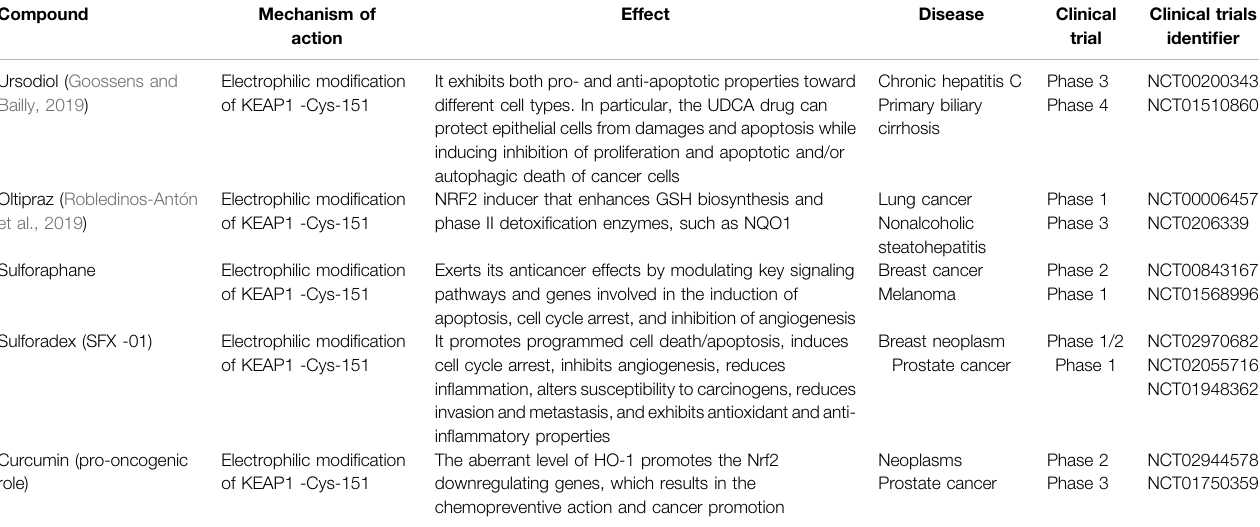
TABLE 3| Anti-oncogenic and pro-oncogenic mechanisms ofNrf2 with various compounds: clinical studies (Su et al., 2018; Goossensand Bailly, 2019; Robledinos-Antón et al., 2019; Nandini et al., 2020).